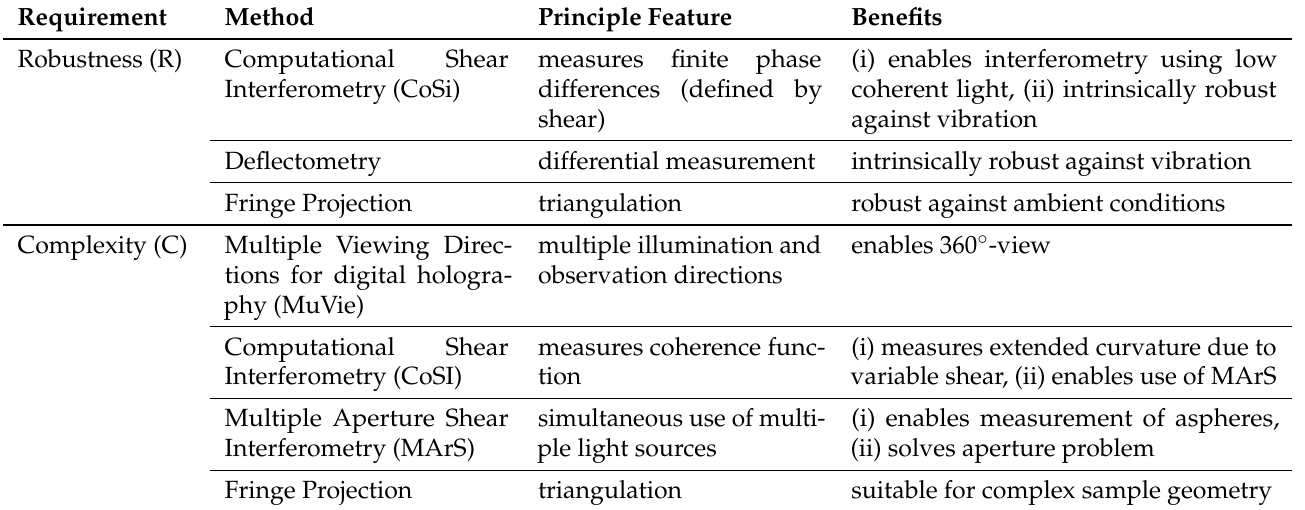
Table 1. Overview over measurement methods discussed in this paper and their impact on robustness (R) and the ability to deal with complex measurement situations (C). Compare to the tetrahedron of optical metrology, as shown in Figure 1.